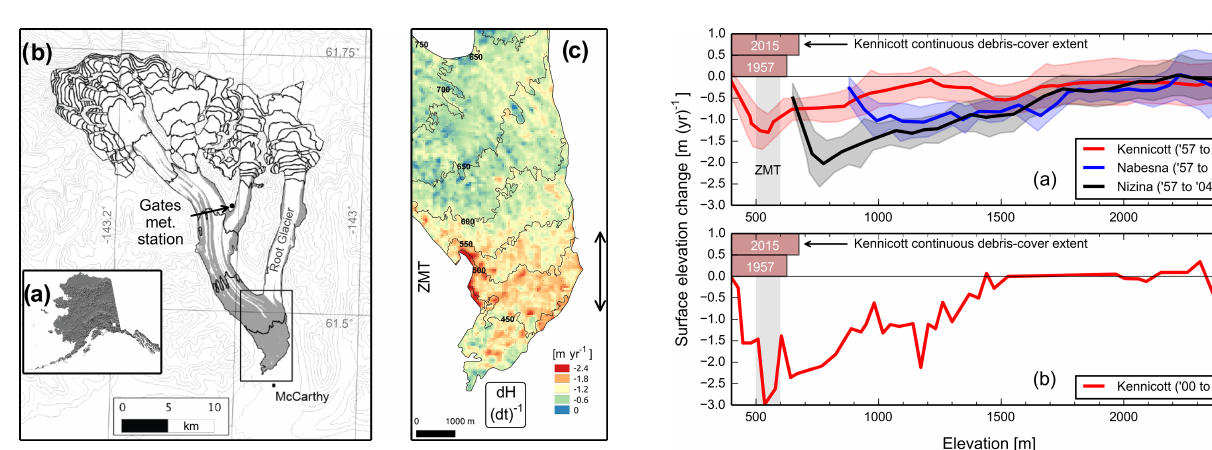
Figure 2. Surface elevation changes from three glaciers in the Wrangell Mountains. Surface elevation change data from Das et al. (2014). Elevations on the x axis are derived from the 1957 digital elevation model (DEM). Take care in comparing these data to those presented in other figures which are referenced to the 2013 glacier surface. (a) Surface elevation change derived from DEM differenc- ing. The shaded areas reflect the standard deviation of DEM differ- encing (see Das et al., 2014). Kennicott Glacier is the only glacier in the figure with a continuous debris cover spanning its entire width. The Nabesna and Nizina glaciers have individual medial moraines but the majority of the glaciers’ termini are debris-free. The vertical grey bar is the zone of maximum thinning corrected for elevation differences. The greatest change in glacier surface elevation occurs within the portion of the glacier where debris spans the glacier width continuously between 1957 and 2015 (shown as brown bars; see Fig. S21). (b) Surface elevation change derived from laser altimetry profiles differenced from a DEM from 2000 to 2007. See Das et al. (2014) for the laser altimetry path and a discussion of